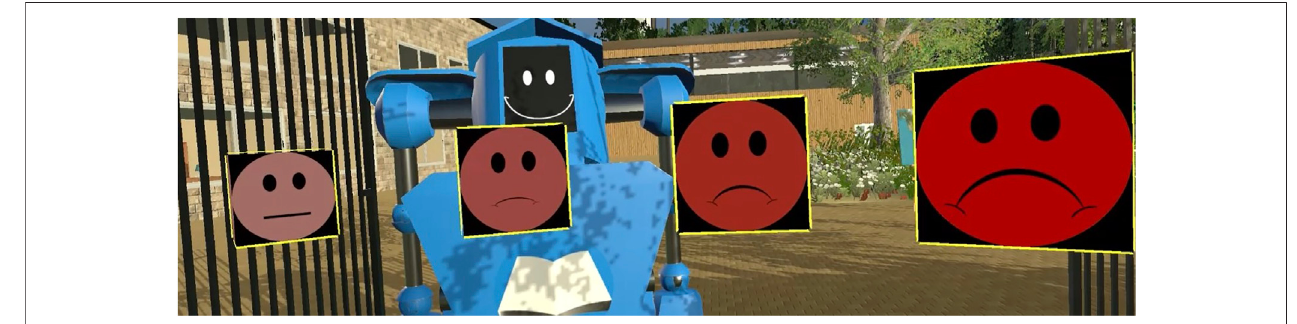
FIGURE 1 | The negative 4-point smiley scale in front of robot Marvin during the